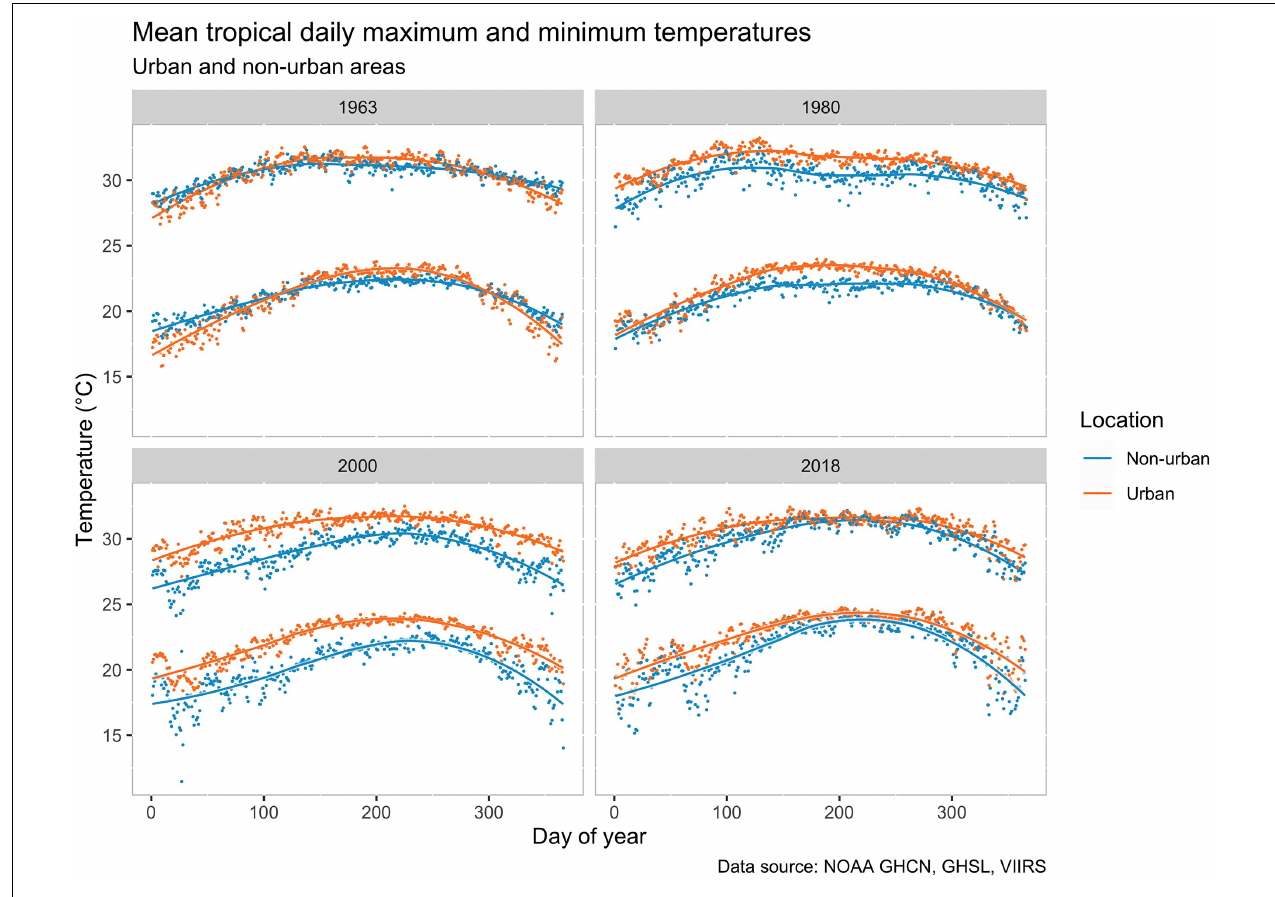
FIGURE 5 | Change in mean tropical daily maximum and minimum temperatures over 55 years in urban and non-urban areas. The higher points and curves on each mini-plot represent the maximum temperatures and the lower points and curves represent the minimum temperatures. Data source: NOAA, GHCN.